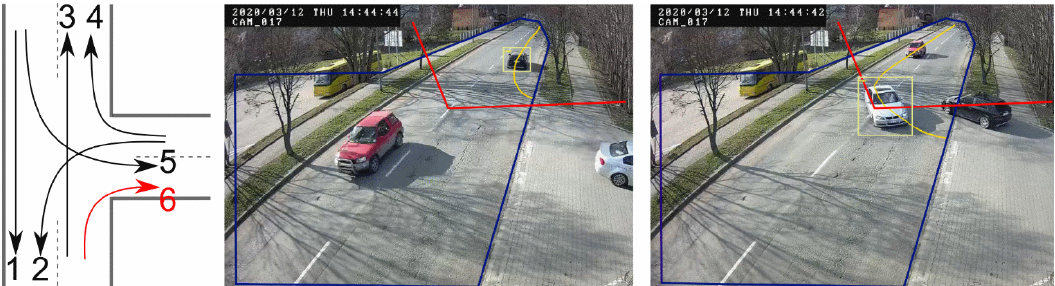
Figure 7. Possible trajectories of vehicles (trajectory 6 is not tracked) and examples of tracking for trajectories 4 and 5. Blue line marks the region of interest—objects outside are excluded from tracking. Red line is a line of detection—vehicles crossing this line are automatically assigned to trajectory 1 or 3, depending on the direction they move. For clarity, each of the vehicle tracked is presented on a separate